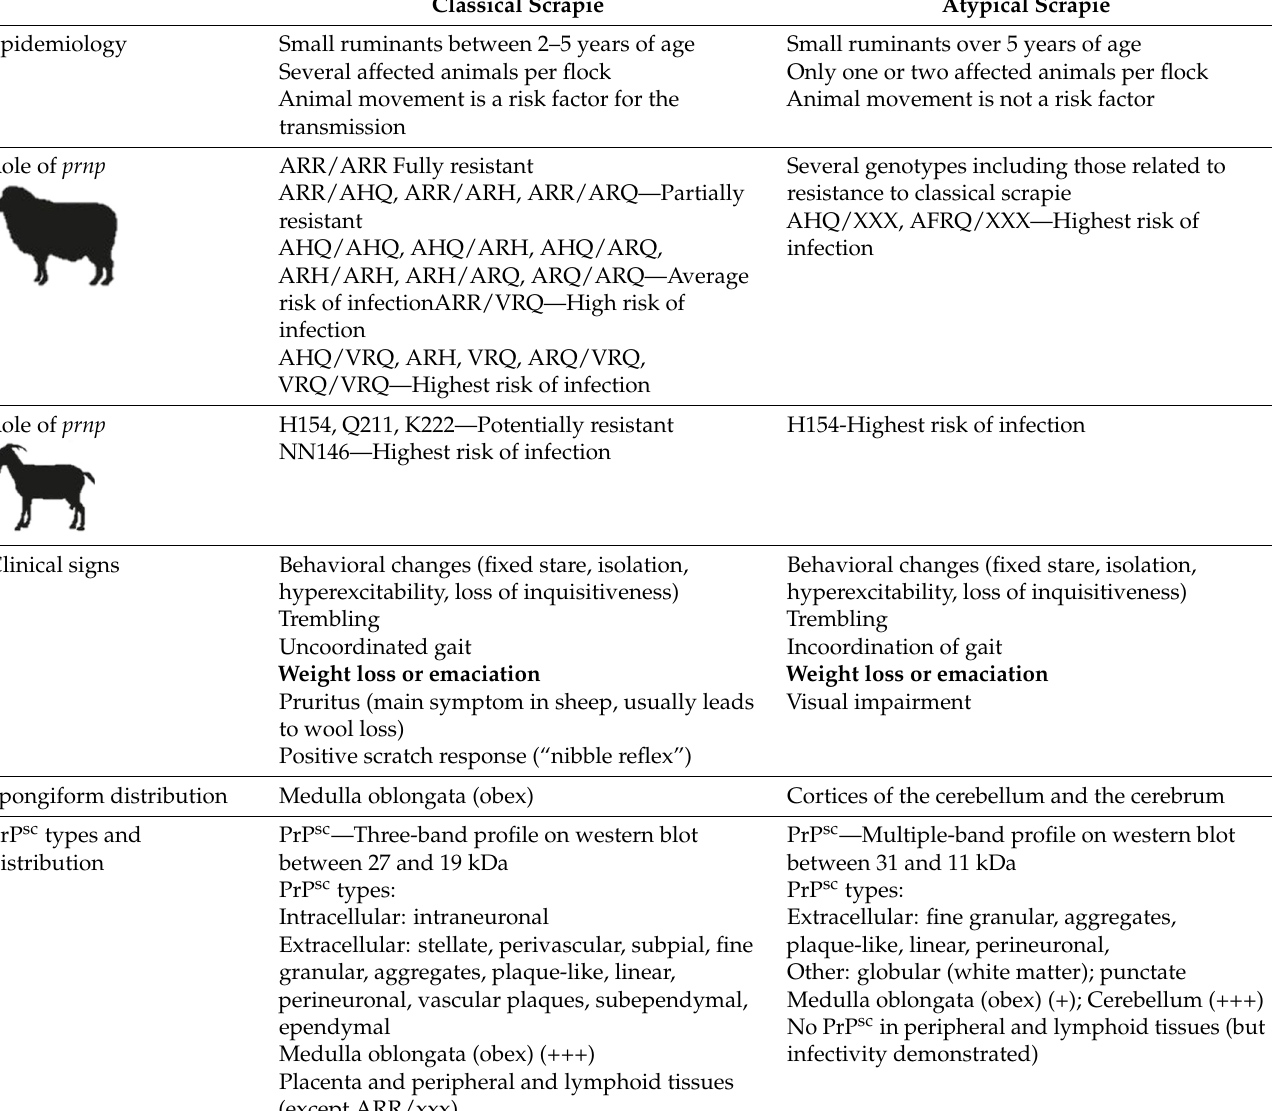
Table 1. Key differential features between classical and atypical scrapie.